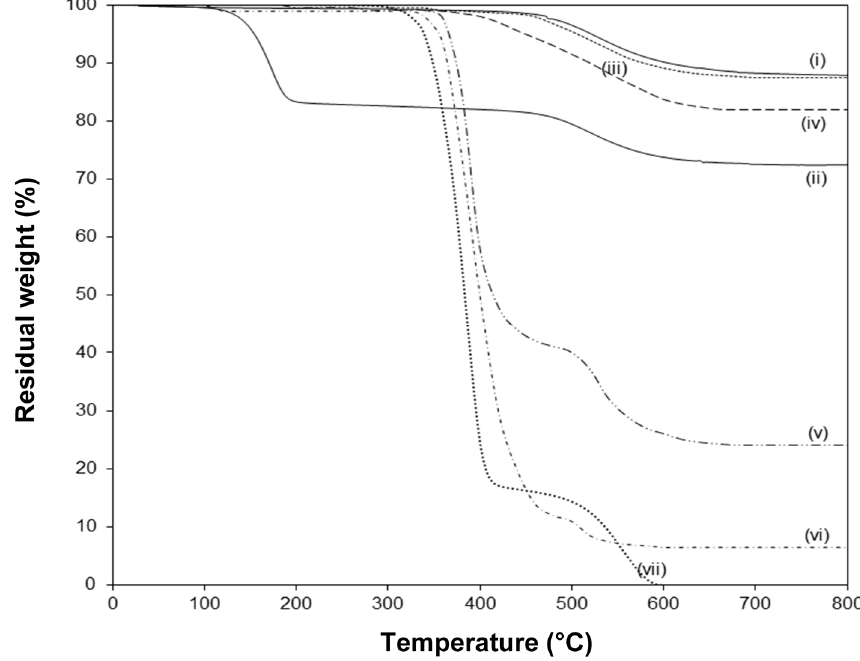
Figure 7. Thermogravimetric analysis (TGA) in air atmosphere of ( i ) pure Kln, ( ii ), Kln/DMSO + water 10h, ( iii ) Kln/a-SMA = 80:20, ( iv ) Kln/a-SMA = 70:30, ( v ) Kln/a-SMA = 50:50, ( vi ) Kln/a-SMA = 30:70, ( vii ) pure